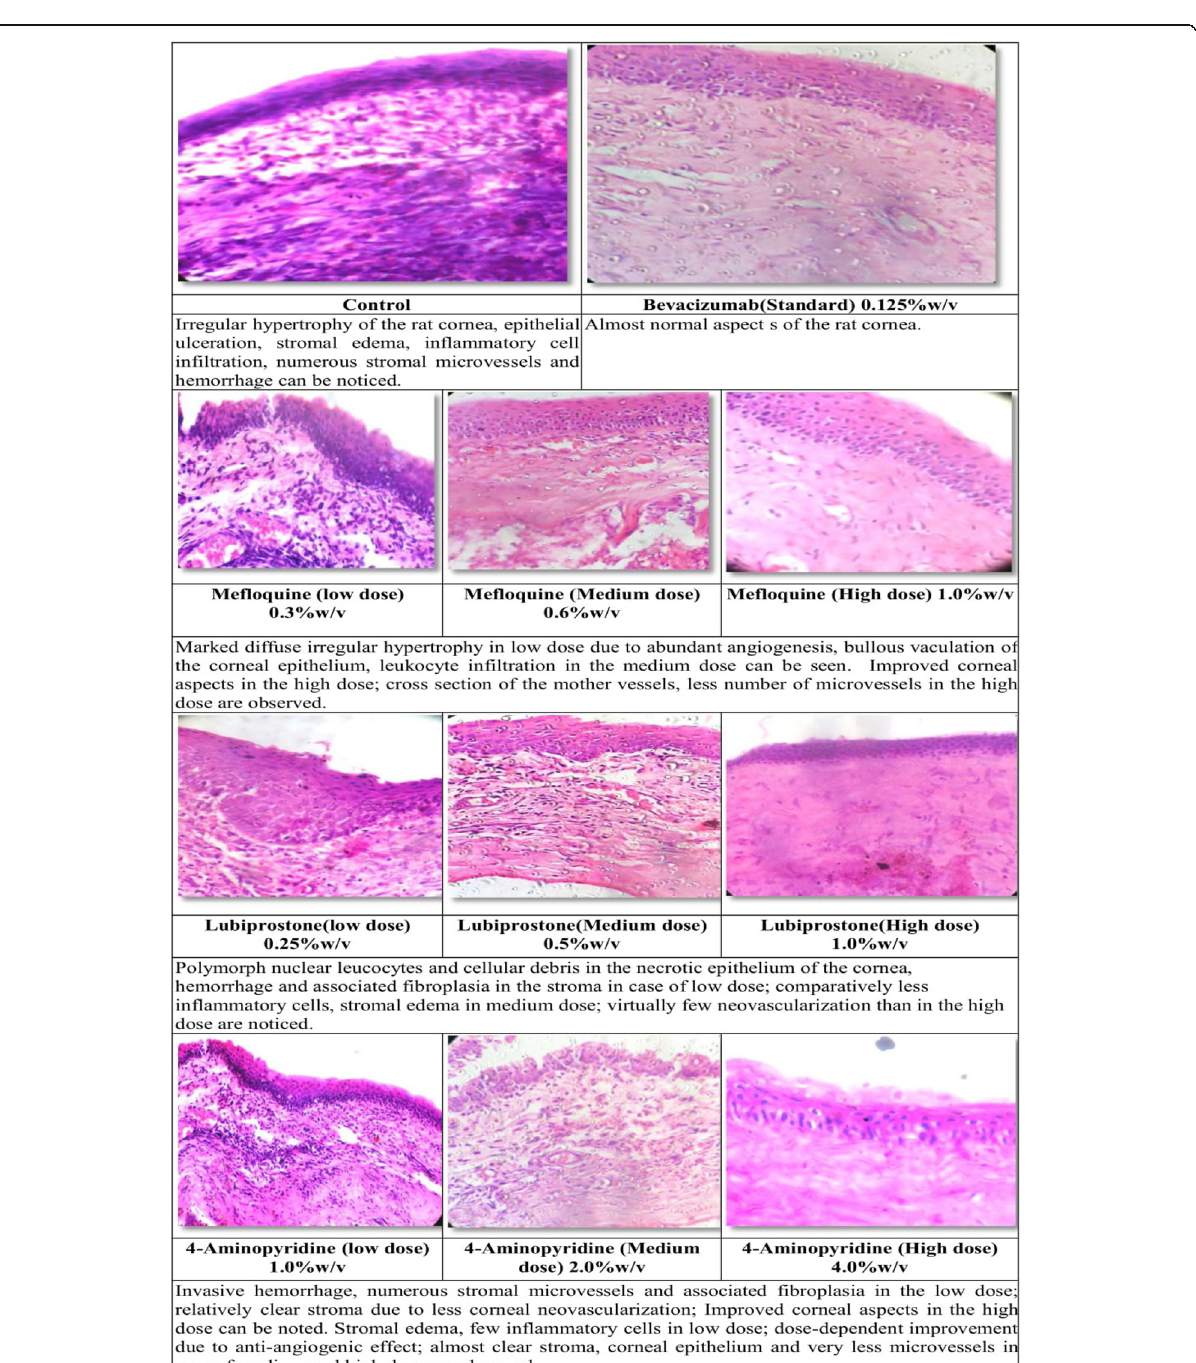
Fig. 2 Photographs representing the histopathology of cornea in control, standard, and test drug